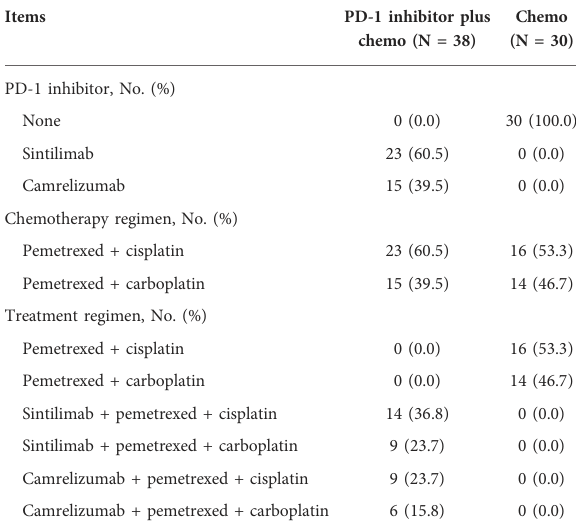
TABLE 1 Treatment information. TABLE 2 Clinical